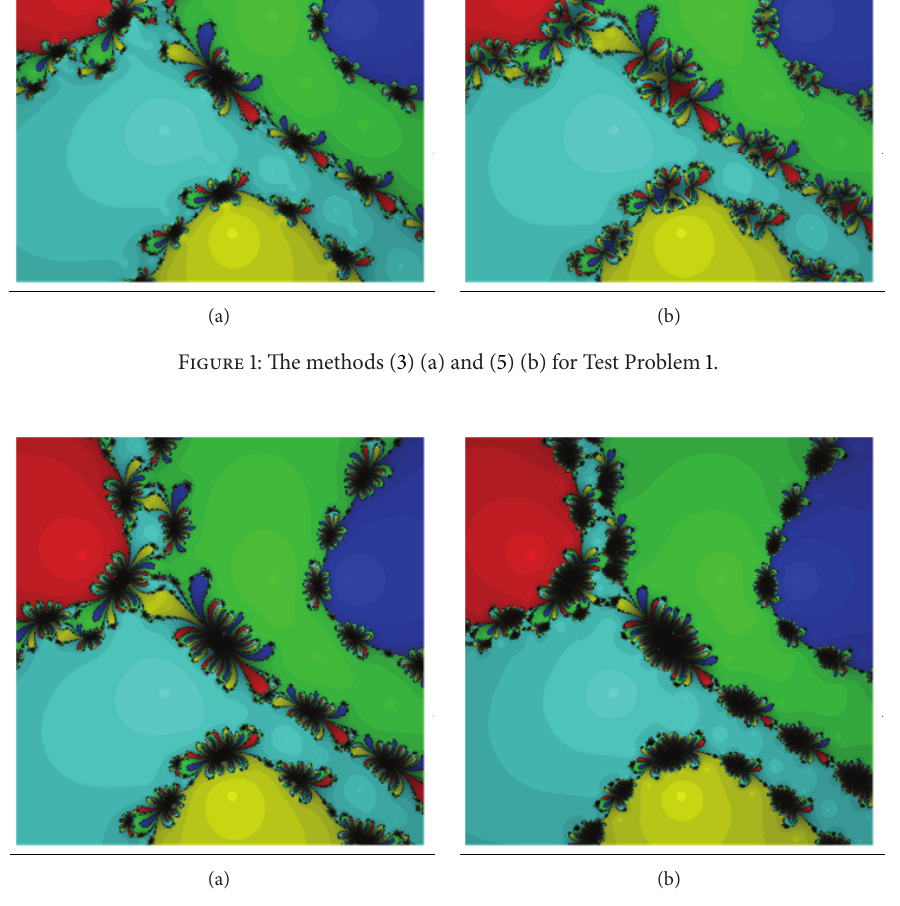
Figure 2: The methods (6) (a) and (14) (b) for Test Problem 1.